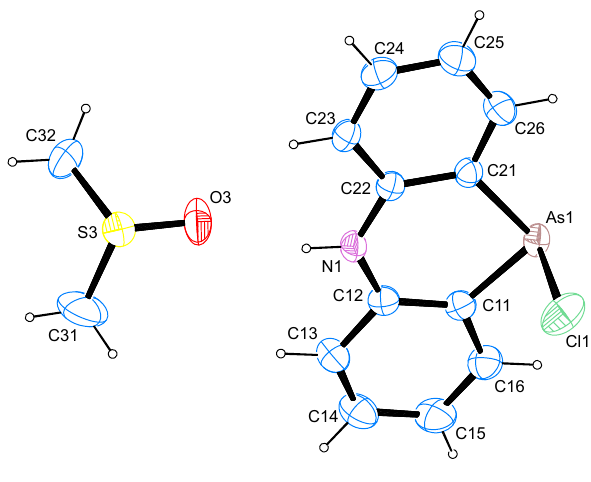
Table  : Fractional atomic coordinates and isotropic or equivalent isotropic displacement parameters (Å 